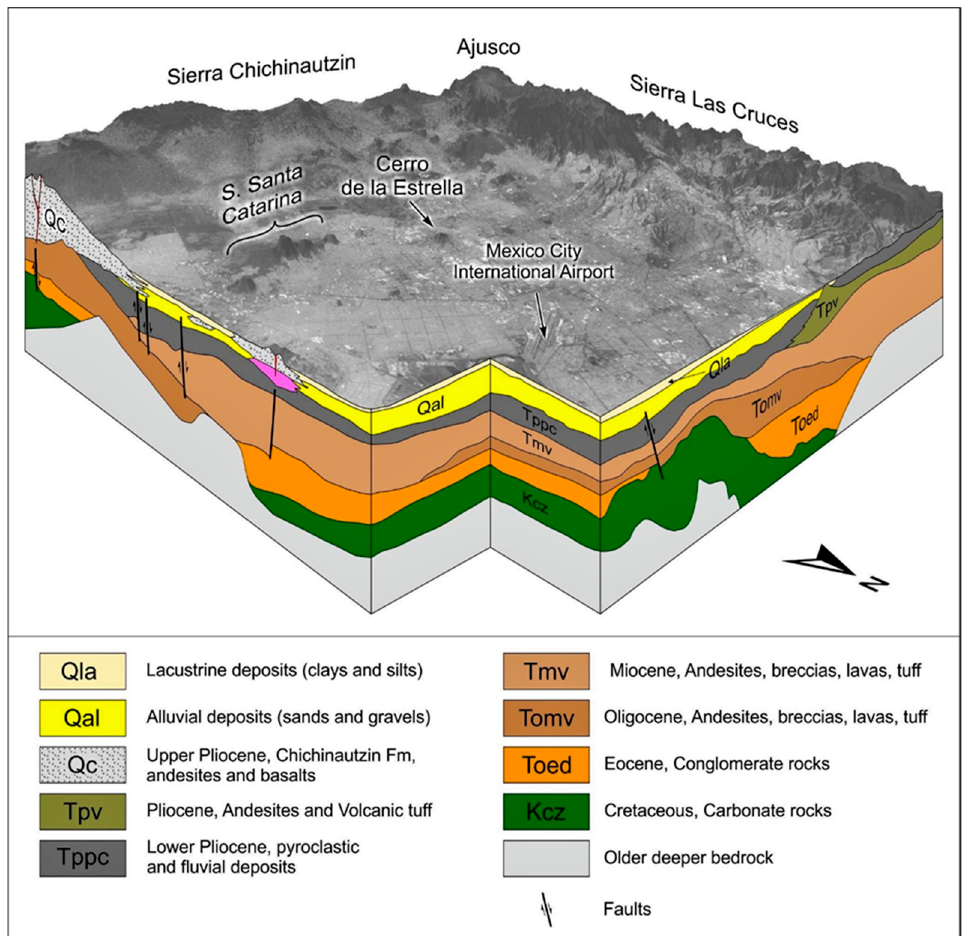
Figure 6. Schematic geological model of the Mexico Basin; its location is shown in Figure 4 as CC’-DD’.